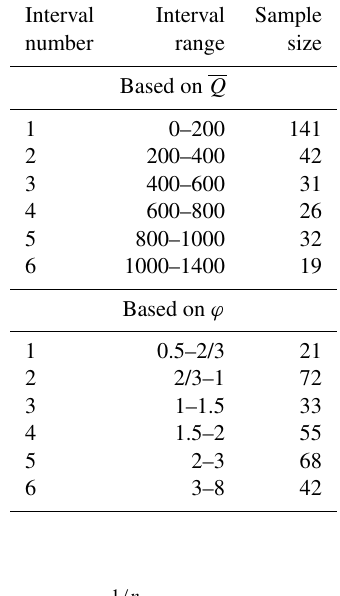
Table 1. Details of the interval partitions based on observed mean annual runoff Q and aridity index ϕ